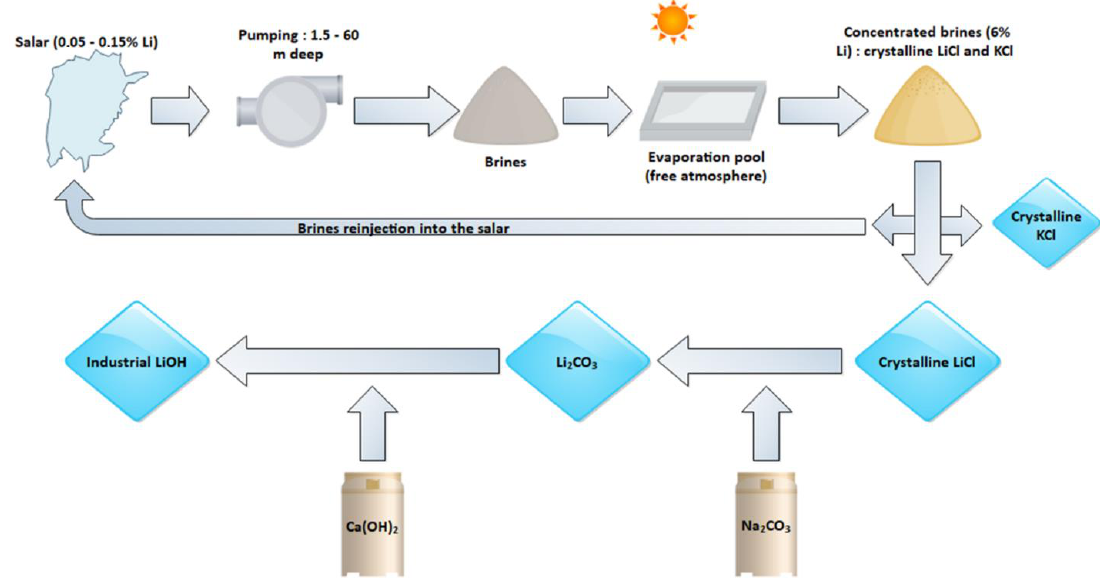
Figure 12. Flow sheets for production of lithium compounds from brines.